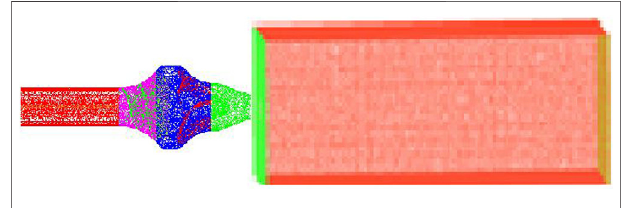
FIGURE 3 | Overall water area grid diagram of water jet propulsion